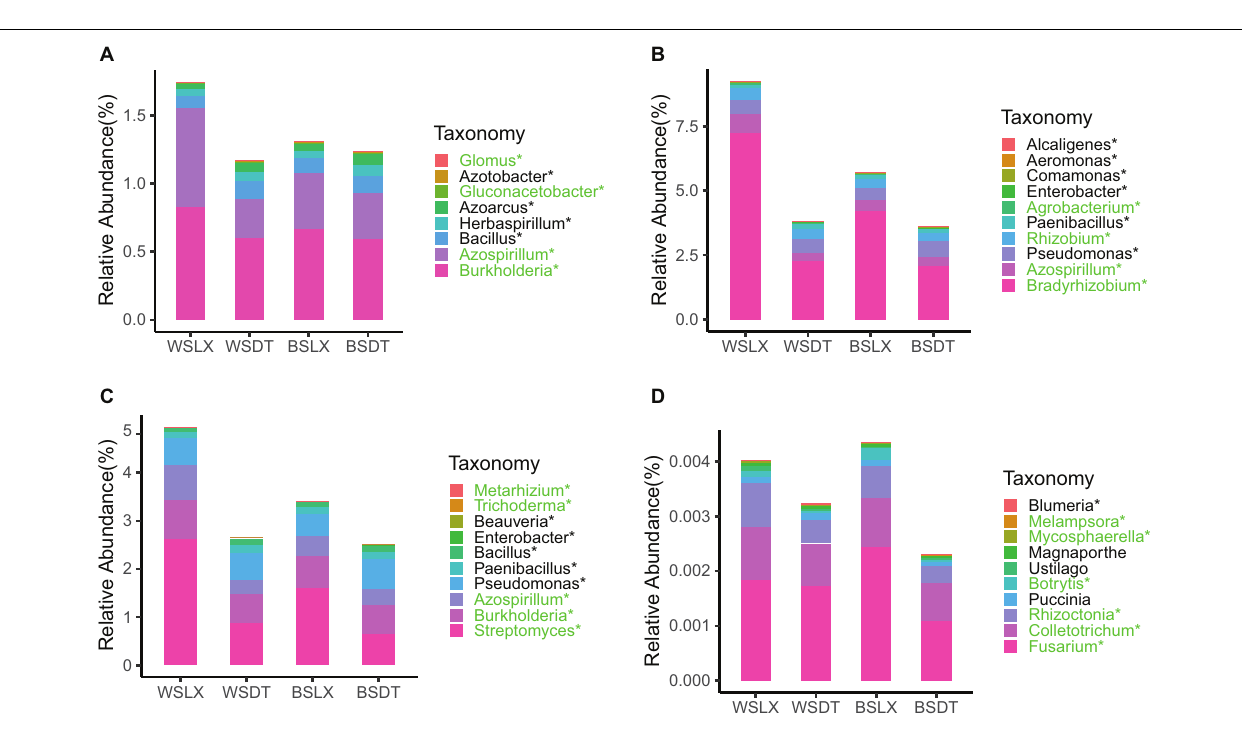
FIGURE 6 | Core genera involved in plant growth-promoting rhizobacteria (PGPR) or plant pathogens in cropland planting ( n = 52) and understory planting ( n = 70) patterns across different sites based on metagenomic data. Detailed relative abundances of core rhizosphere microbiomes involved in (A) nitrogen cycle, (B) plant growth regulator, (C) biological control agent, and (D) plant pathogens. Asterisk indicates a significant difference with P < 0.05 (MW test). Green indicates the relative abundances of core rhizosphere microbiomes is significantly higher in understory planting than in cropland planting. Black indicates the relative abundances of core rhizosphere microbiomes is significantly lower in understory planting than in cropland planting. WSDT, rhizosphere soil of cropland planting in Wenshan City; WSLX, rhizosphere soil of understory planting in Wenshan City; BSDT, rhizosphere soil of cropland planting in Baise City; BSLX, rhizosphere soil of understory planting in Baise